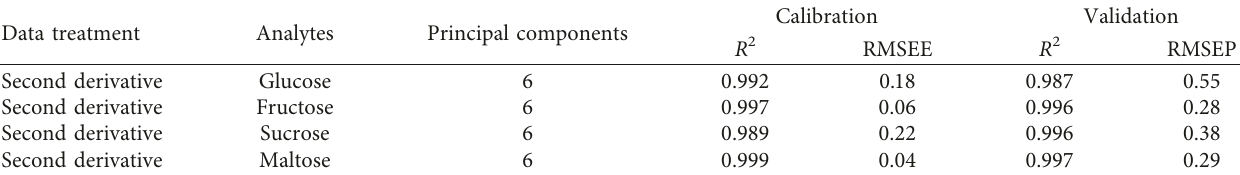
Table 3: Results of MIR-PLS calibration models for the determination of sugars in alcoholic